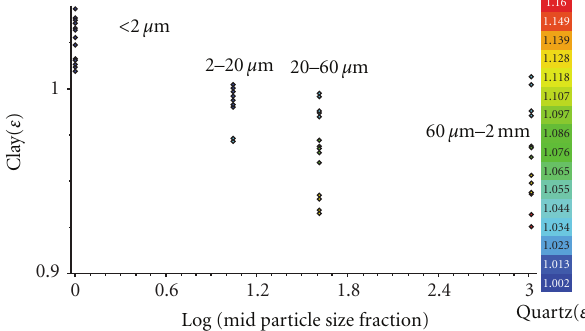
Figure 8: Relationship between the clay content spectral parameter and the log of the particle size colour coded by the quartz content spectral parameter (e.g., low quartz content: blue, high quartz: